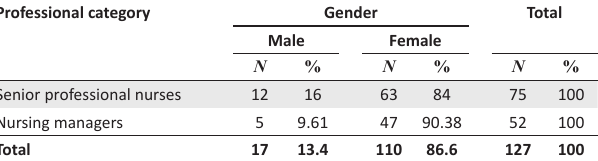
TABLE 1: Professional category on gender. Professional